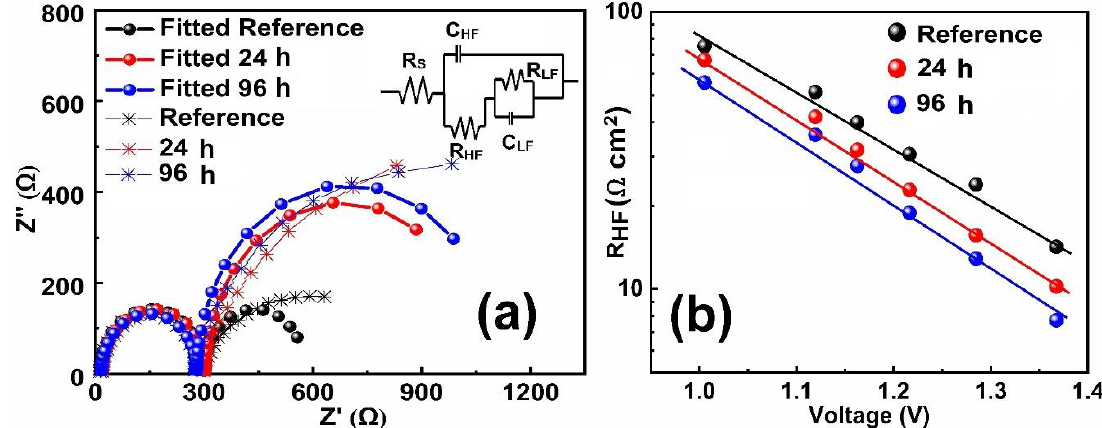
Figure 2. ( a ) A commonly used electrical equivalent circuit for impedance spectroscopy (IS) fitting of the PSCs and the IS spectra measured at built-in potential (V bi ) under AM 1.5 G light illumination. ( b ) High-frequency resistance (R HF ) vs. voltage under AM 1.5 G light illumination over time.